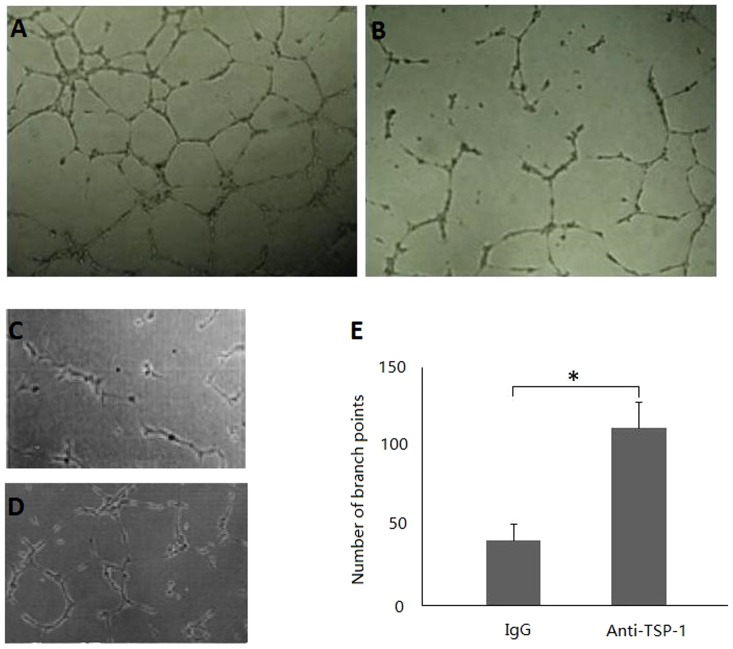
Effect of platelet-released cytokines on angiogenic activity of HUVEC.Representative photographs of the tube formation assay after 18-incubation with platelet-released cytokines are shown in panels A (the patients platelet-released cytokines added) and B (healthy controls platelet-released cytokines added). Preincubation of platelet lysates with IgG control (C) and antiTSP-1 antibody (D). The statistical analysis (E). Bars are means±SD from 4 experiments. * P<0.05 control versus treatment.